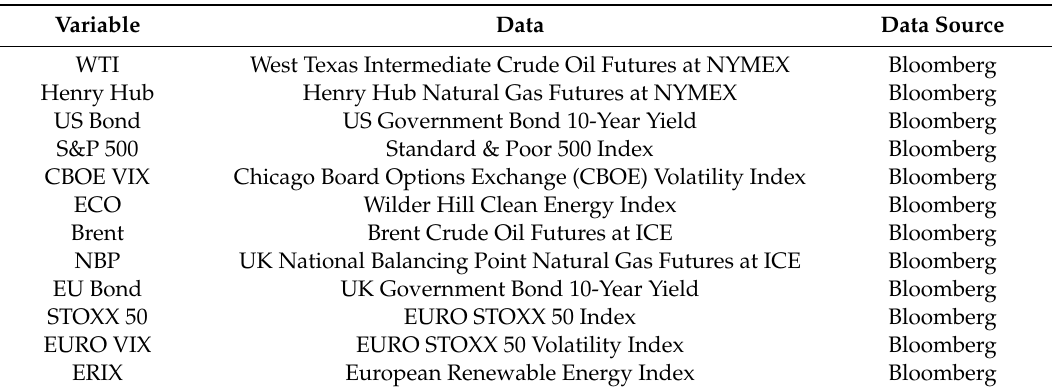
Table 1. Variables in the